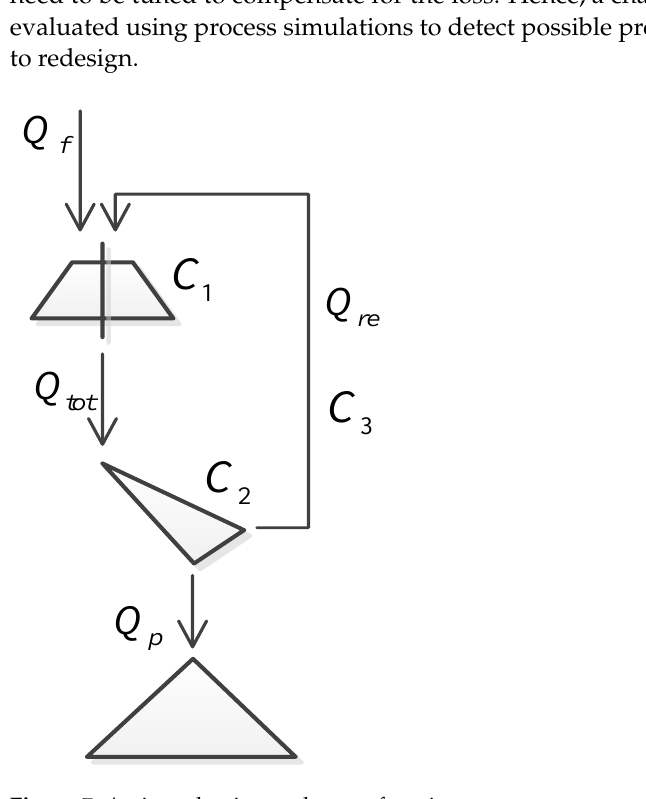
Figure 7. An introduction to the cost function.